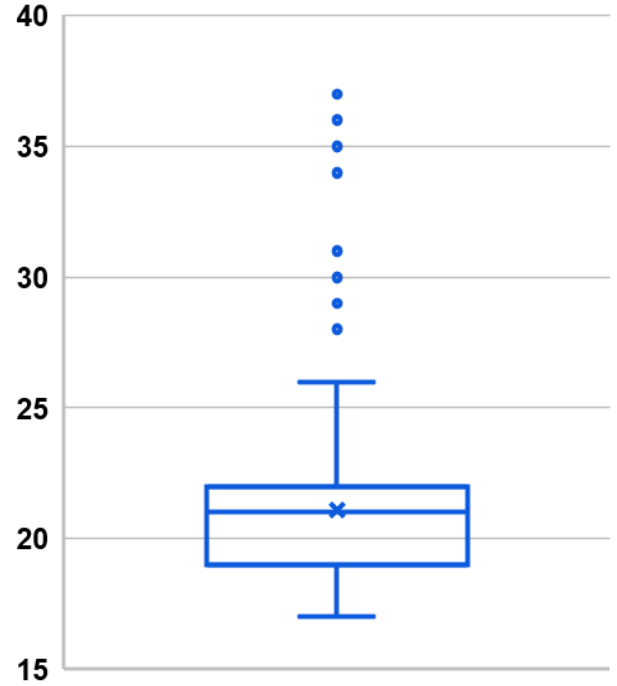
Figure 3. Age composition of the